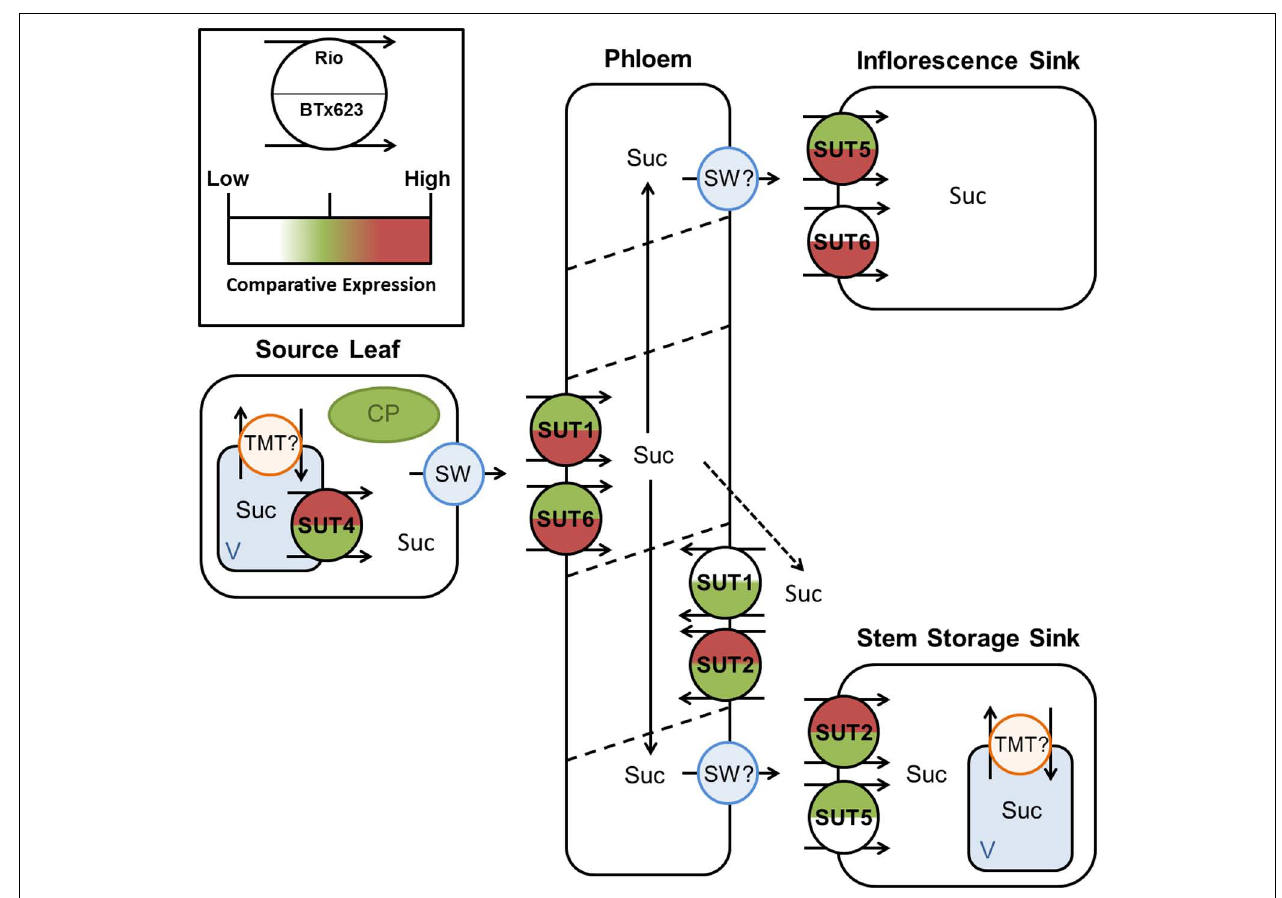
FIGURE 9 | Predicted source–transport–sink pathway in Sorghum at anthesis. Sucrose is released from source vacuoles (V) by SbSUT4. SbSUT1 and SbSUT6 load the phloem. SbSUT1 and SbSUT2 may act to retrieve sucrose leaked from the transport phloem. SbSUT2 and SbSUT5 load sucrose